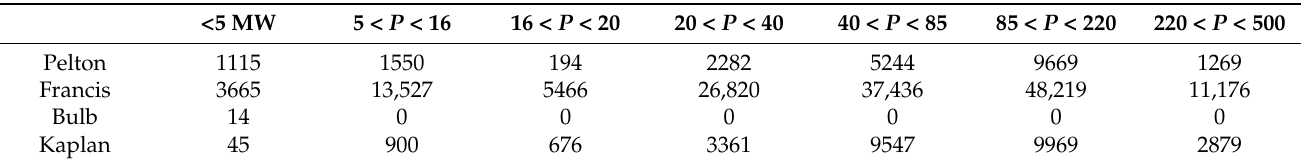
Table 3. Cumulative power P (MW) for each power range and turbine type.